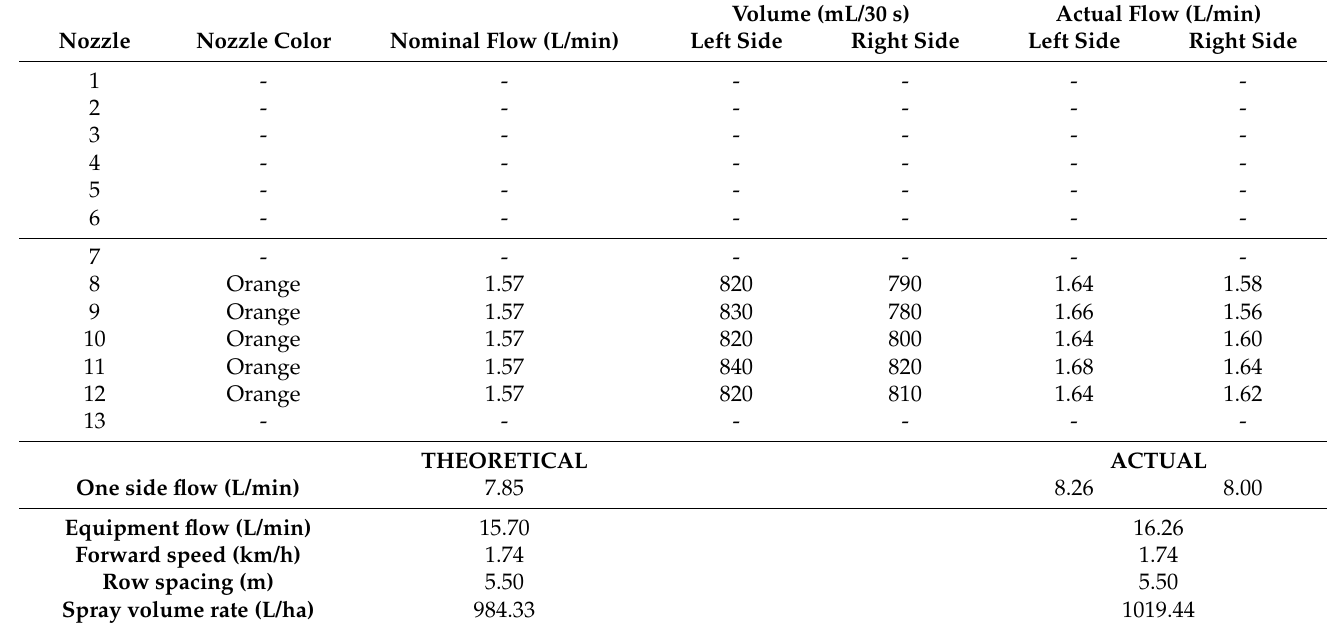
Table A17. Selection and calibration of nozzles for the C1 sprayer, with the following configuration: Adjusted to the vegetation/High & Low fan speed/Low spray volume rate/Conventional nozzles (Fine)/Pressure: 13 bar.